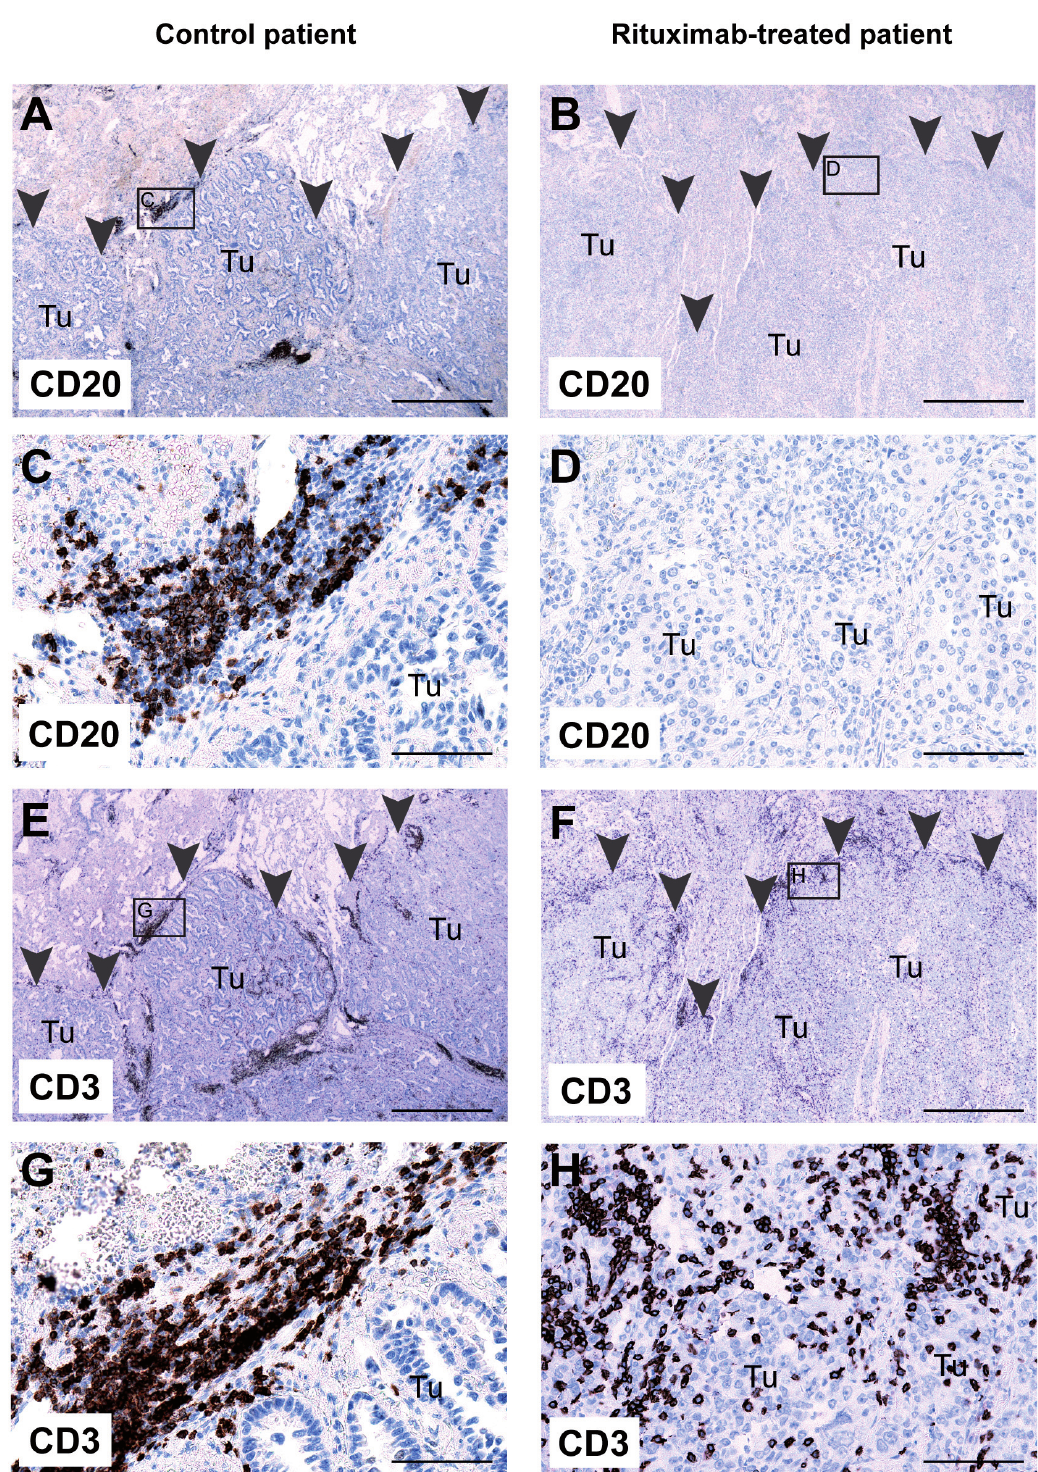
Figure 3. Absence of CD20 + B cells in primary lung tumor from a patient treated with rituximab. Lung tissue sections from a control patient ( left ) and from a rituximab-treated patient ( right ) were stained with anti-CD20 ( A – D ) or anti-CD3 ( E – H ) antibodies, and contrastained with hematoxylin. Both patients were diagnosed with lung adenocarcinoma. Arrowheads delineate the border of the tumor. Small boxes in A , B , E , and F indicate magnified areas in C , D , G , and H , respectively. Tu, tumor tissue. A , B , E , and F : 20 × magnification; scalebar = 1 mm. C , D , G , and H : 200 × magnification; scalebar = 100